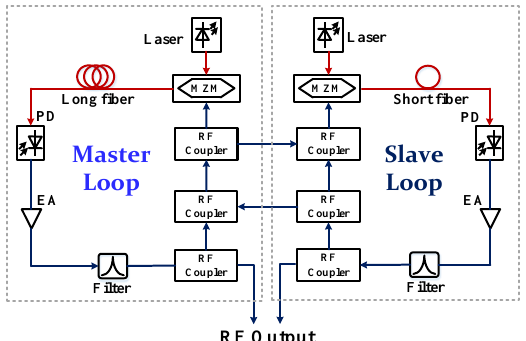
Figure 8. The schematic diagram of the dual-injection-locked OEO. Reprinted with permission from Ref. [41], OSA, 2018 .